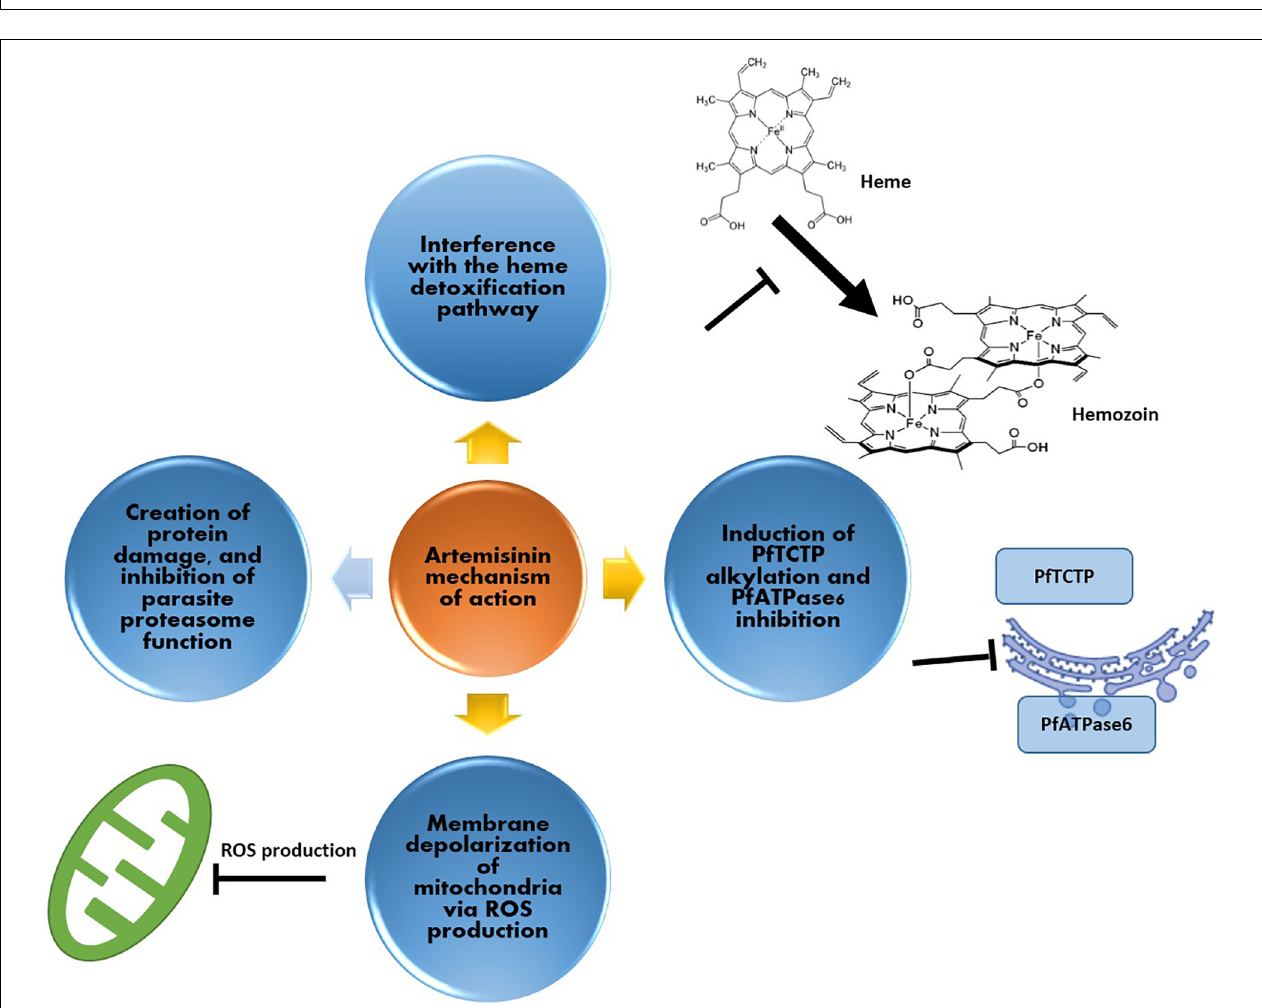
FIGURE 2 | Artemisinin mechanism of action against malaria parasite; (i) production of ROS for depolarization of the parasite’s mitochondria, (ii) interference with the heme detoxification pathway of red blood cells (iii) induction of alkylation and inhibition of cellular elements such as PfATPase6 and (iv) via protein damage, and inhibition of parasite proteasome